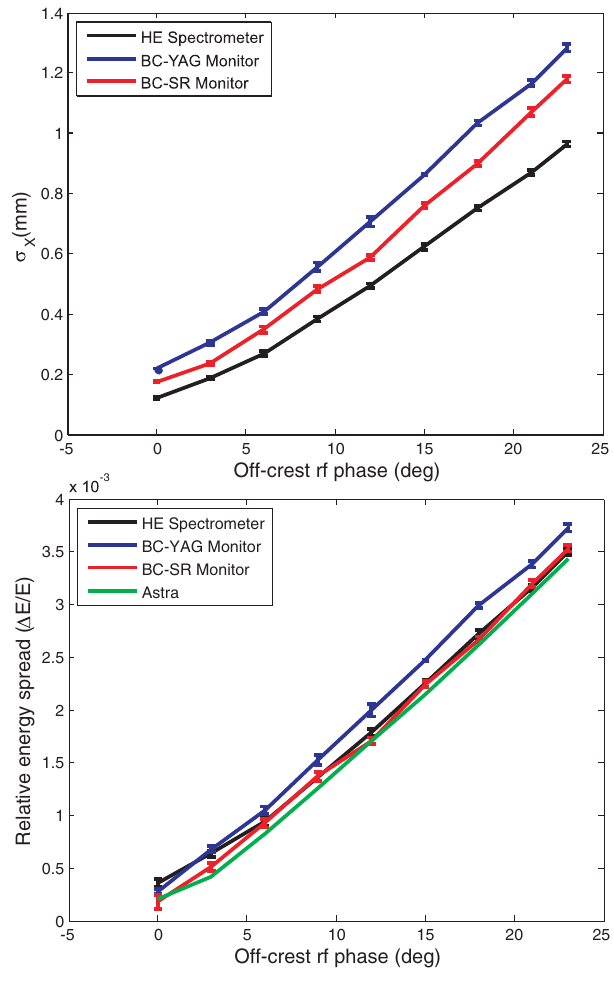
FIG. 46. Top: Horizontal beam size versus off-crest rf phase as measured with the high-energy spectrometer, the YAG screen in the bunch compressor (BC-YAG), and the synchrotron radiation monitor in the bunch compressor (BC-SR) for a beam energy of 230 MeV and a bunch charge of 12 pC. Bottom: Relative energy spreads derived from the measurements, compared to the result of a numerical simulation based on A STRA